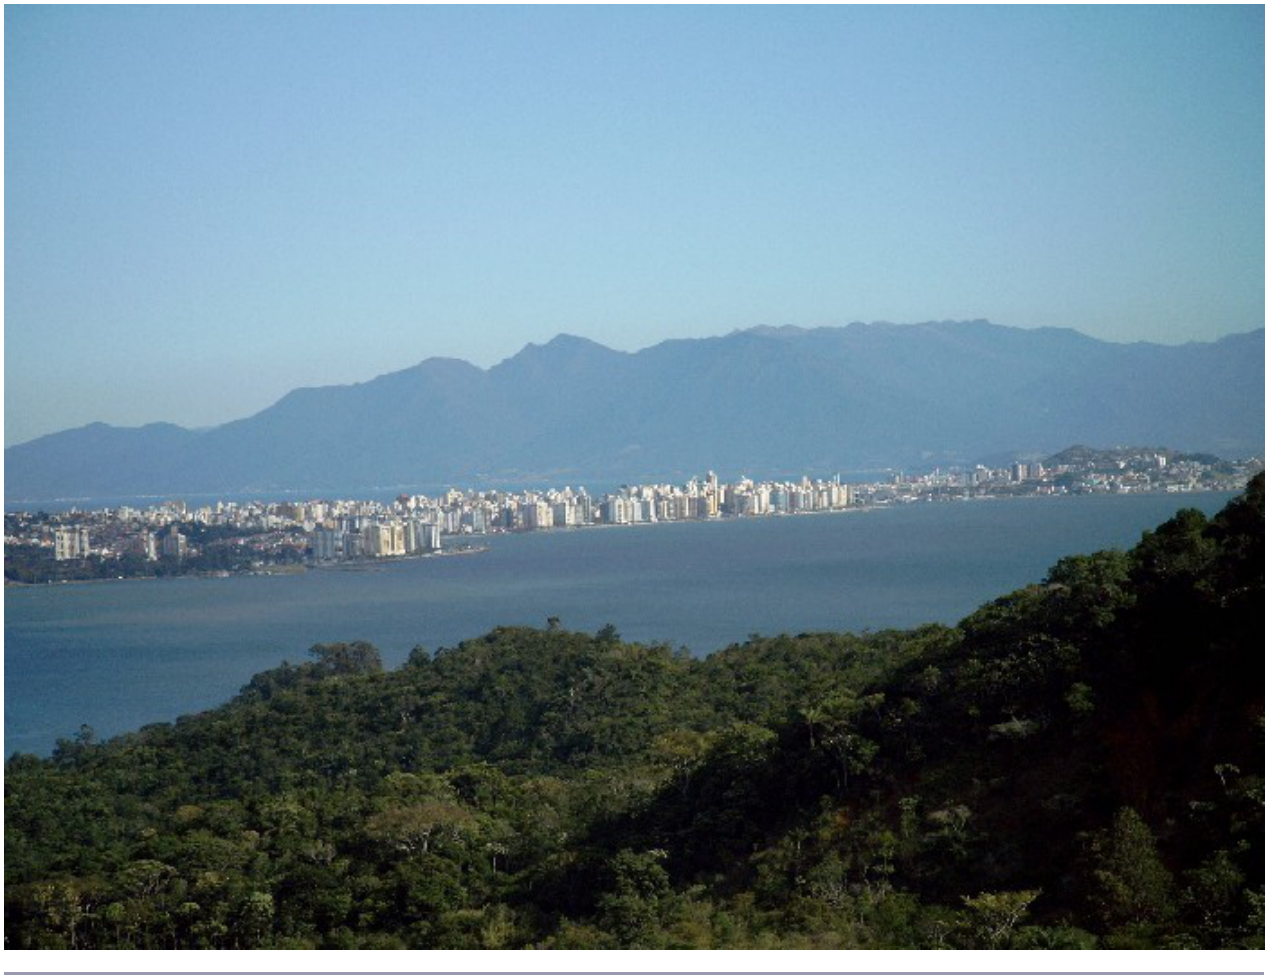
Fig. 3. Photograph of the metropolitan Florianópolis city center and its vicinity. The view is from the Desterro Environmental Conservation Unit ( Unidade de Conservação Ambiental do Desterro ), Santa Catarina Island. Photo: S. R. Baptista, 14 June